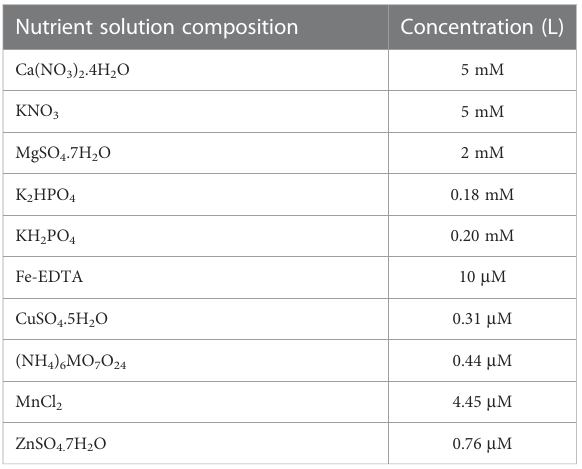
TABLE 1 The nutrient solution composition used in this